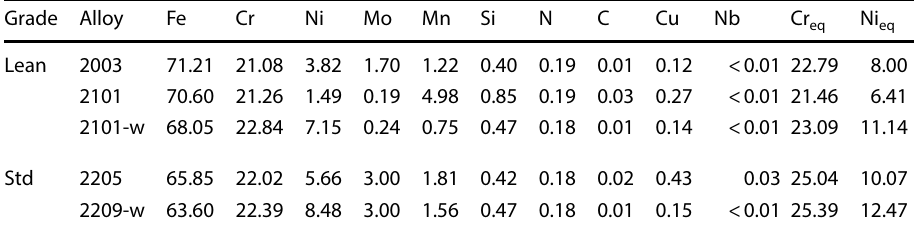
Grade Alloy Fe Cr